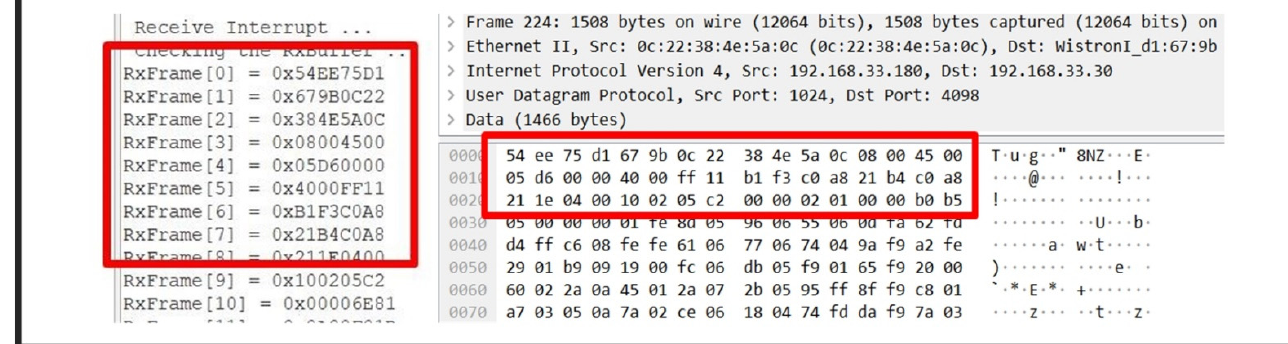
Figure 8. Verification of the data received by the control board.